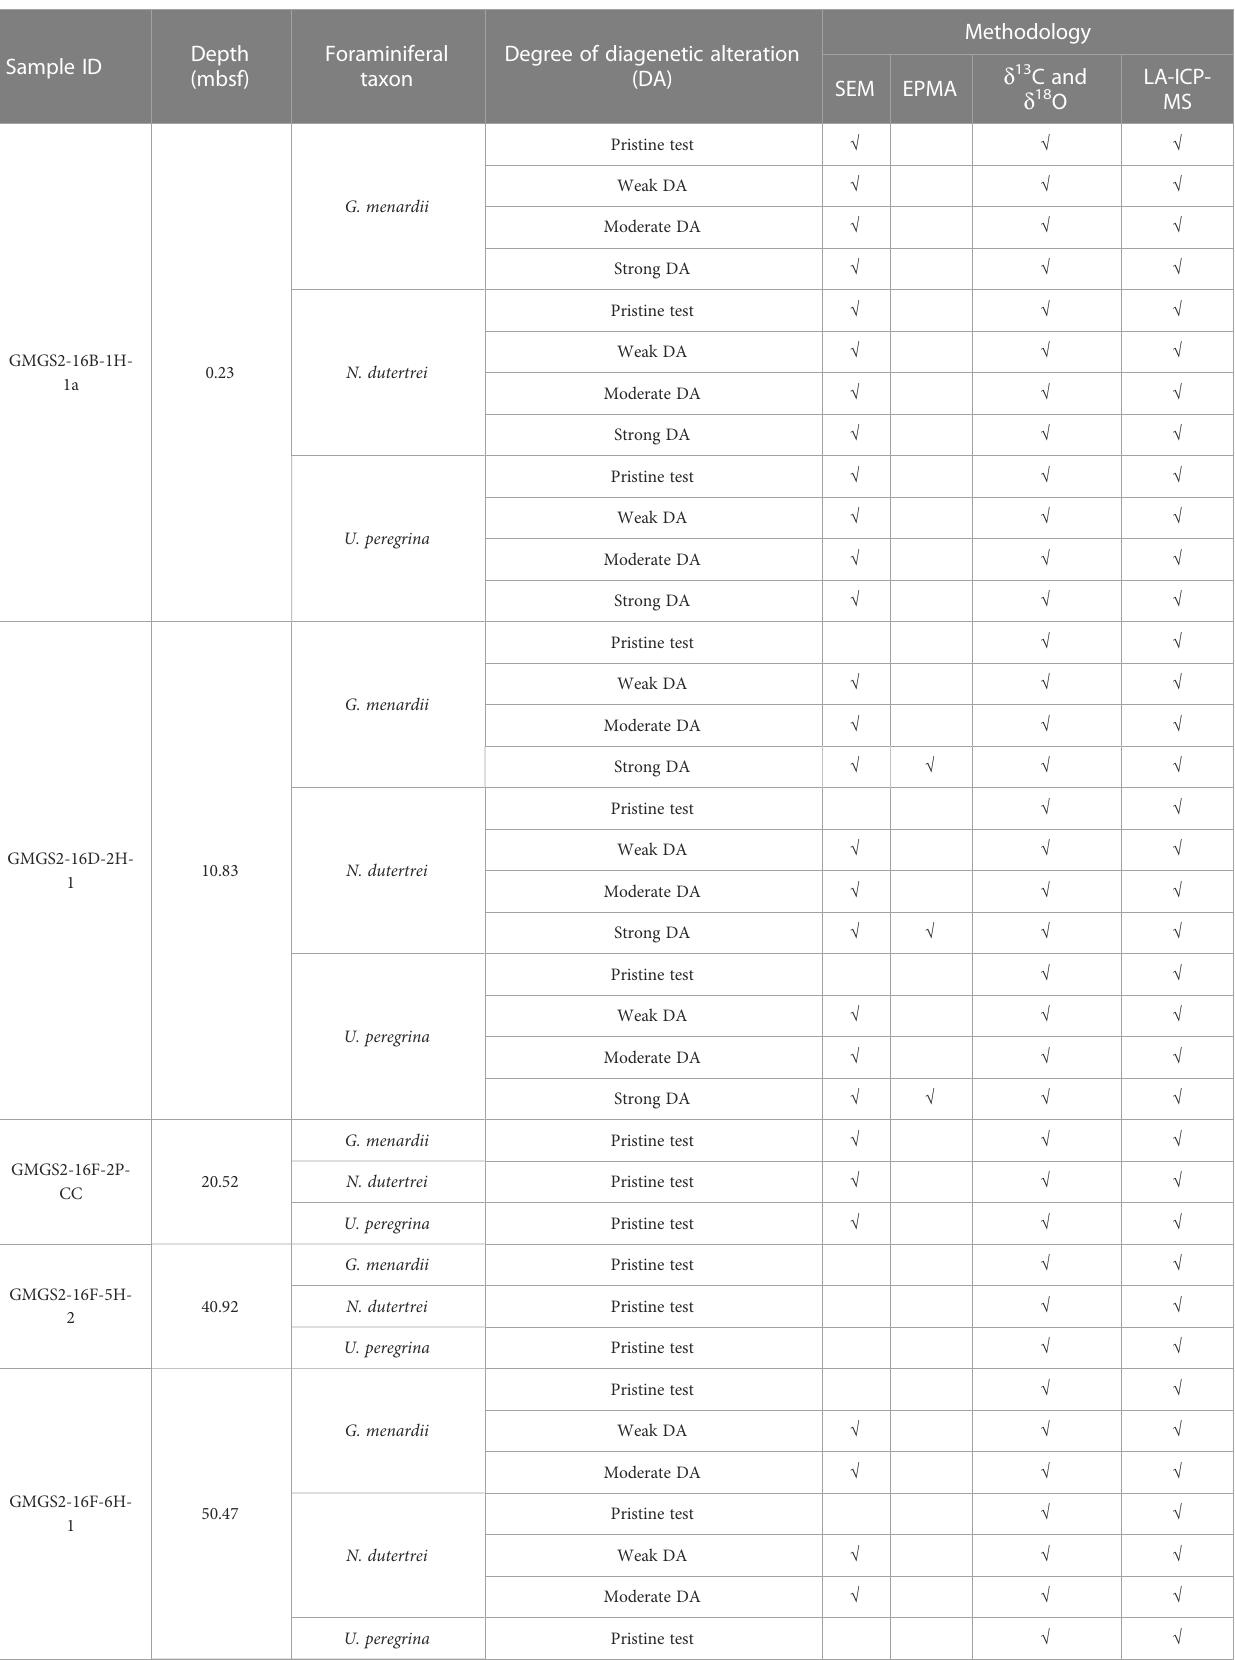
TABLE 1 Overview of the analytical techniques for each